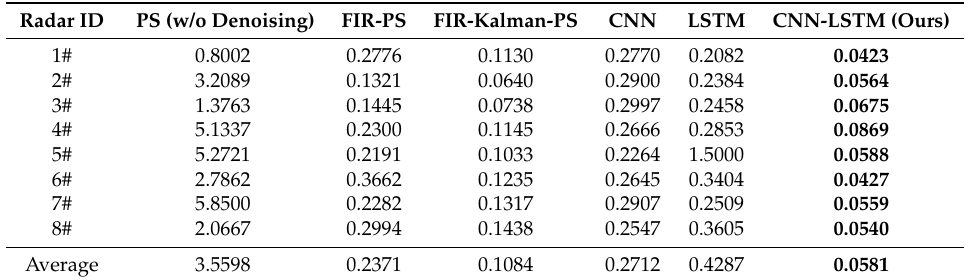
Table 4. Comparison of the proposed method with different methods on testing set (root mean square error, RMSE).